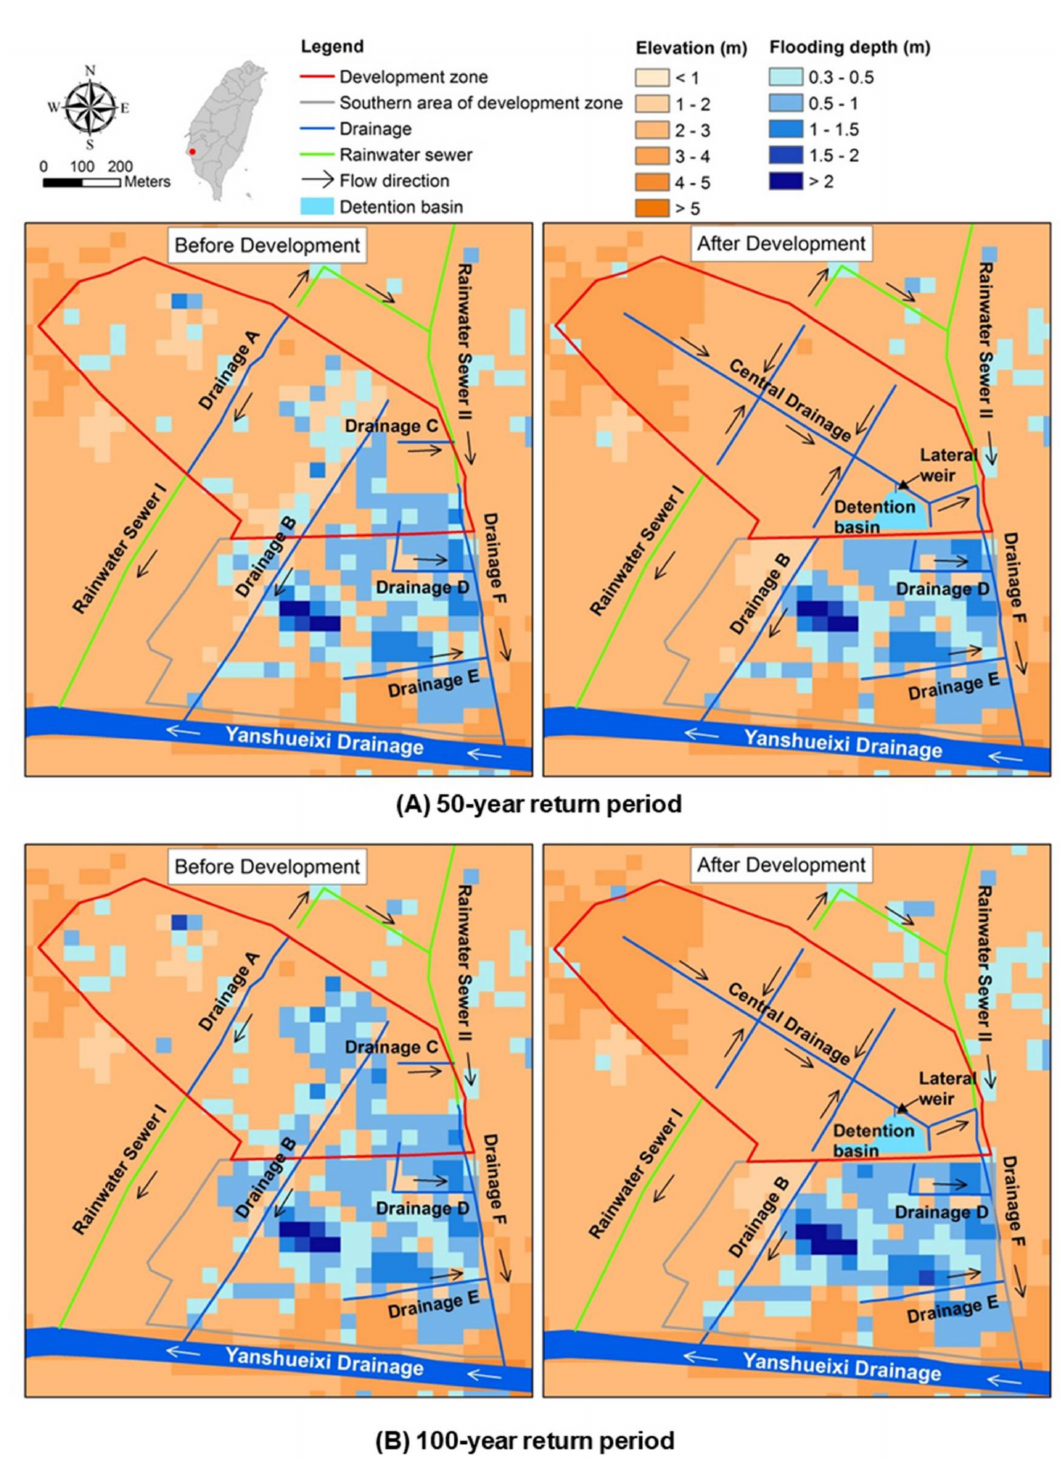
Figure 7. ( A ) The flooding range maps of 50-year return periods before and after land development. ( B ) The flooding range maps of 100-year return periods before and after land